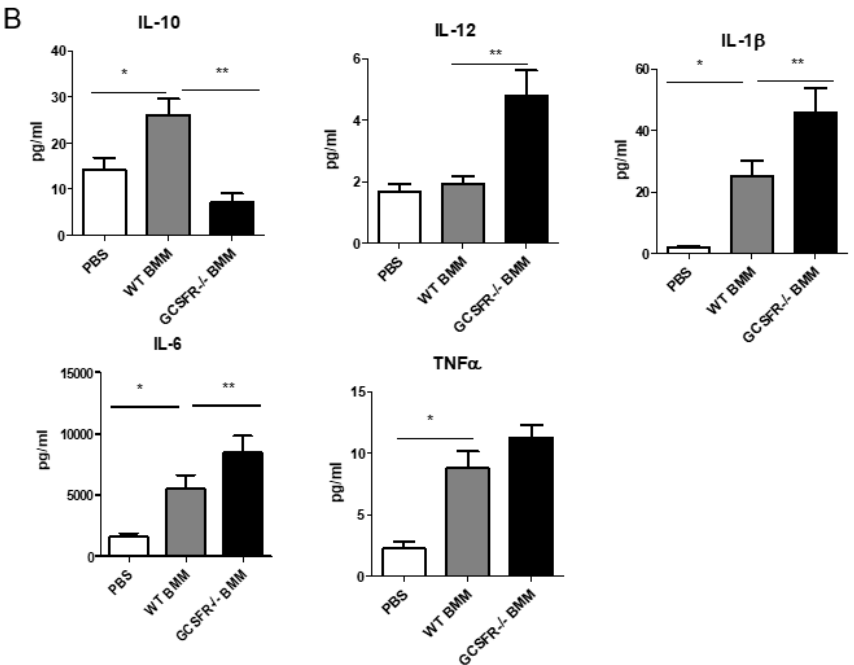
Figure 5. Tumor supernatant cytokine levels differ between control (PBS injections), WT BMM adoptive transfer and G-CSFR − / − BMM adoptive transfer mice in ( A ) MC38 ( B ) PK5L1940 tumors as shown by multiplex bead array. n = 10; * p and ** p = < 0.05.